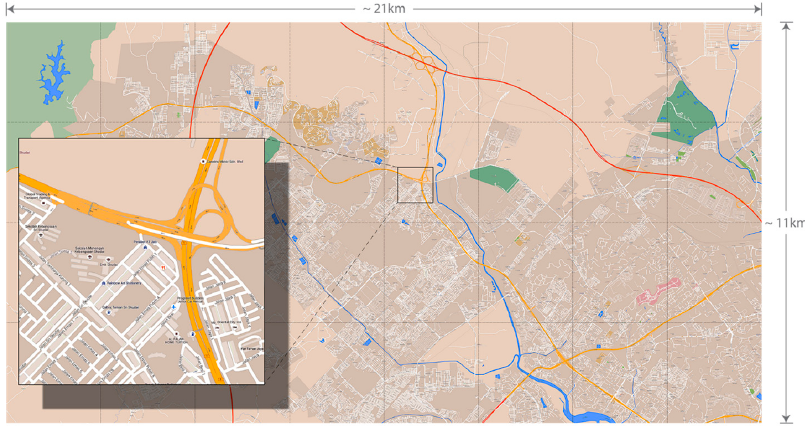
Figure 4. The Skudai simulation area (map data provided by OpenStreetMap, 2015). Table 5. Simulation parameters.